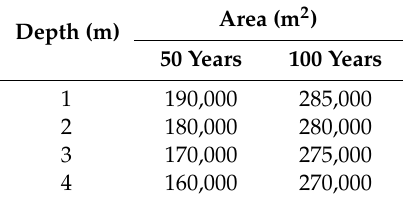
Figure 9. Soil profile for the current and proposed scenario. Table 4. New dimensions of the pond for 50- and 100-year return periods.